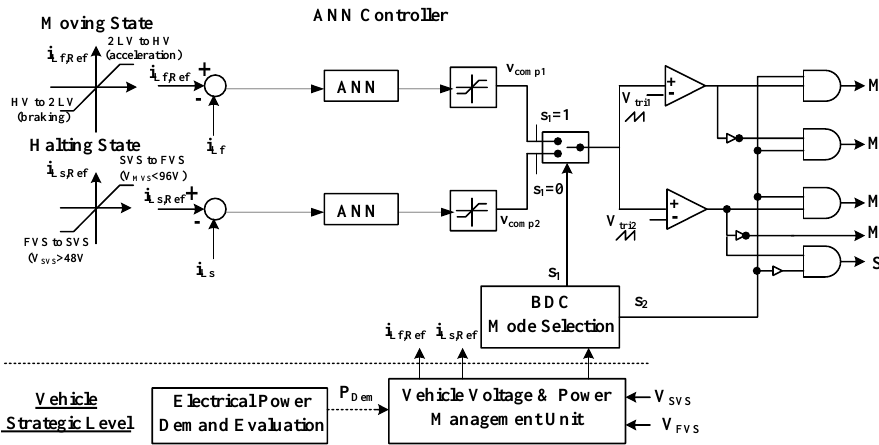
Figure 10. Block diagram for feedback loop control technique.